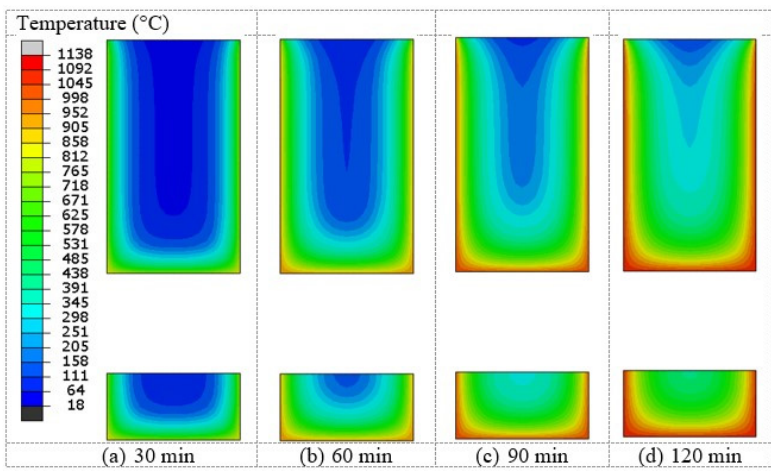
Figure 8 – Thermal field for different ISO 834 times (beam with